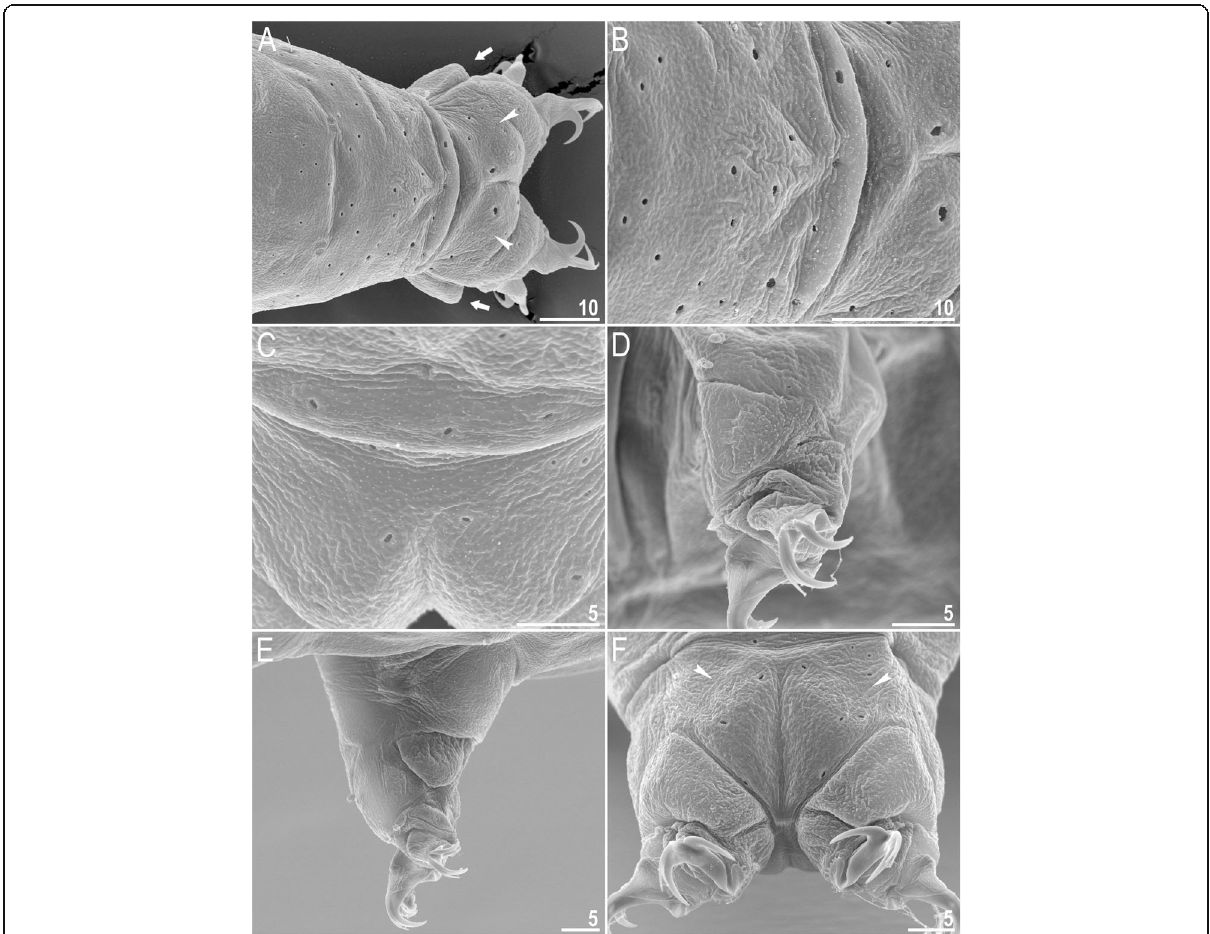
Fig. 23 Macrobiotus ripperi sp. nov. from Poland (PL.015) – body and leg cuticle morphology seen with SEM: a – c – band of caudal granulation on the last body segment; d – granulation on the external surface of leg II; e – internal surface of leg III with evident pulvinus; f – granulation on dorsal surface of leg IV. Filled indented arrowheads indicate sparse granulation in the caudal band, arrows indicate lateral gibbosities on the IV leg – a male secondary sexual character. Scale bar in μ